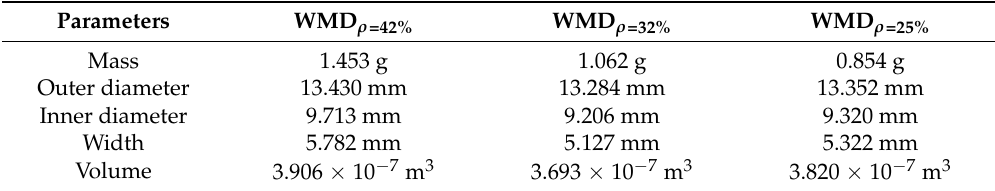
Table 1. Dimensions of test wire mesh dampers (WMDs) 1